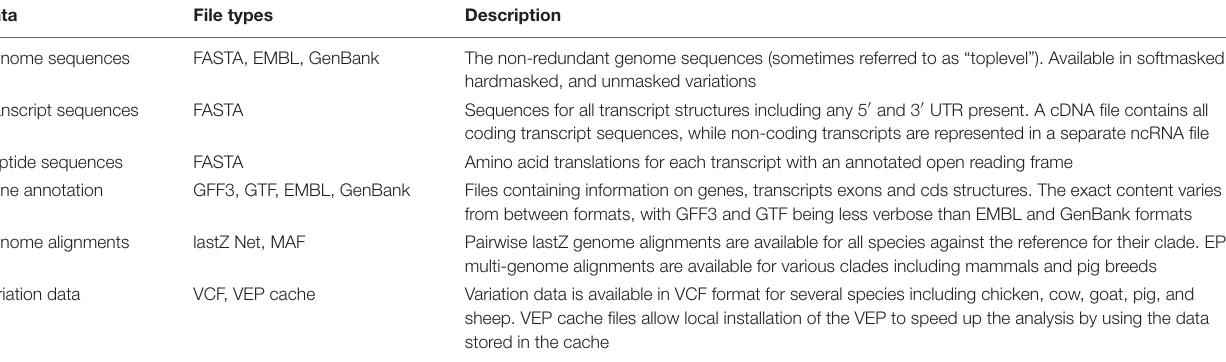
TABLE 5 | Selected files available on the Ensembl FTP site for livestock